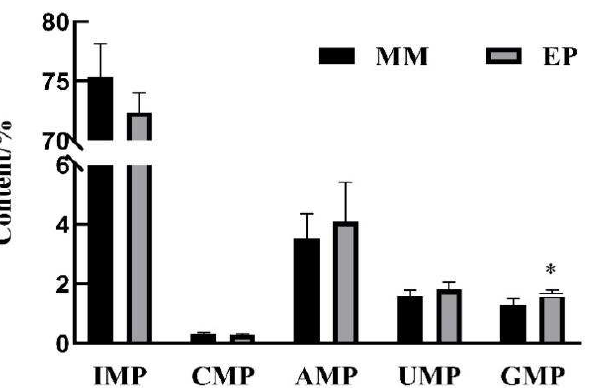
Figure 7. Comparison of nucleotide content in largemouth bass muscle in the EM and EP groups. * indicates the statistically significant difference in the EM and EP groups ( p < 0.05).